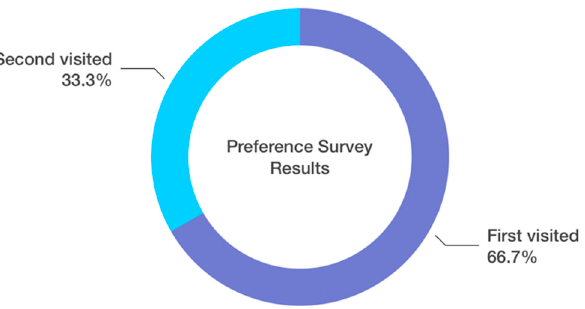
Figure 8. Preference survey results—responses broken down by share between the two versions of the online store.